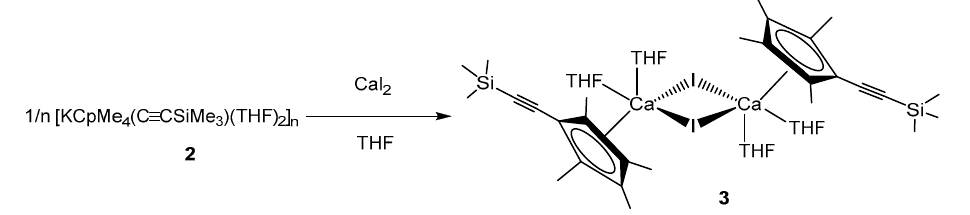
Scheme 3. Conversion of 2 with CaI 2 yields in 3 .